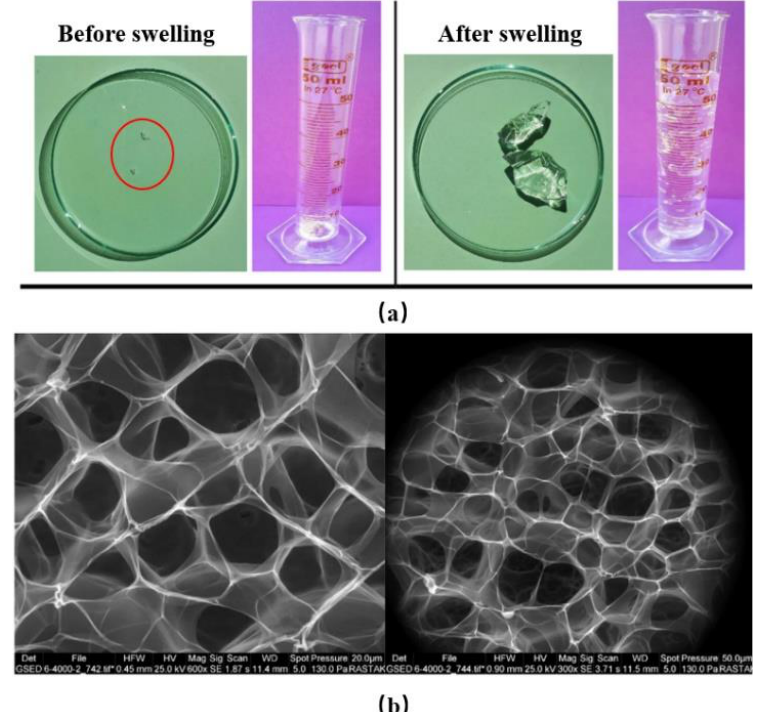
Figure 4. Physical photograph and microstructure of super-swelling PPG before and after swelling. ( a ) Physical photograph of super-swelling PPG before and after swelling; ( b ) microstructure of super-swelling PPG before and after swelling at room temperature. (Reprinted/adapted with permission from Ref. [40]. 2018, Lenji, et al.).